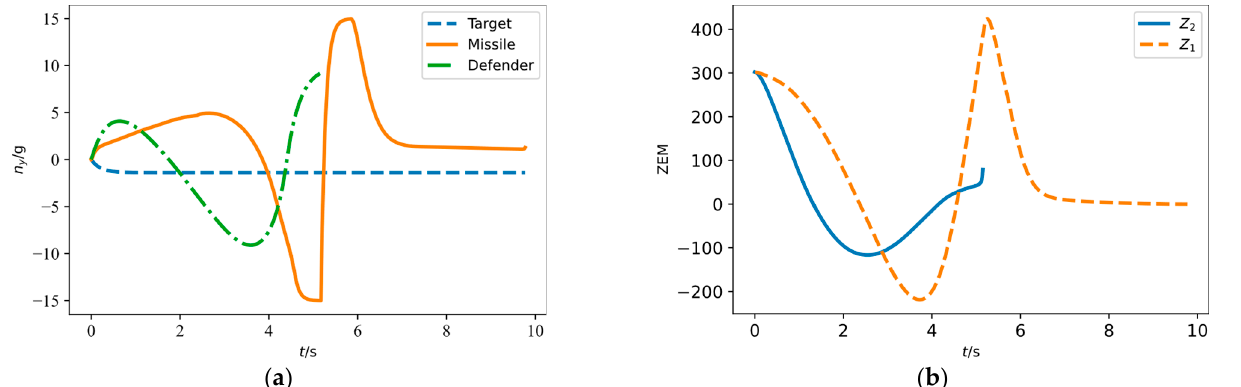
Figure 6. Engagement process in Figure 5a. ( a ) The overload of each vehicle; ( b ) The zero-effort miss Z 1 and Z 2